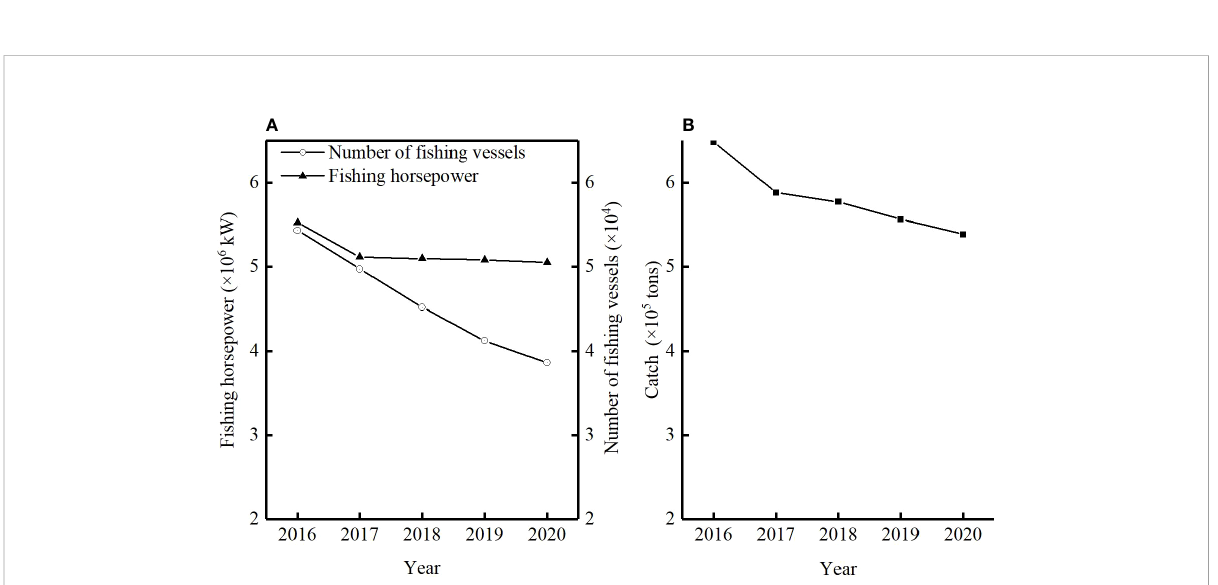
FIGURE 4 Statistics of fi shing horsepower, number of fi shing vessels (A) and catch (B) for T. lepturus in the East China Sea from the Zhejiang, Jiangsu, Shanghai and Fujian province from 2016 to 2020 {data from China Fishery Statistical Yearbook [Fishery Management Bureau of Ministry of Agriculture and Rural Affair (FMBMARA), (2000 –